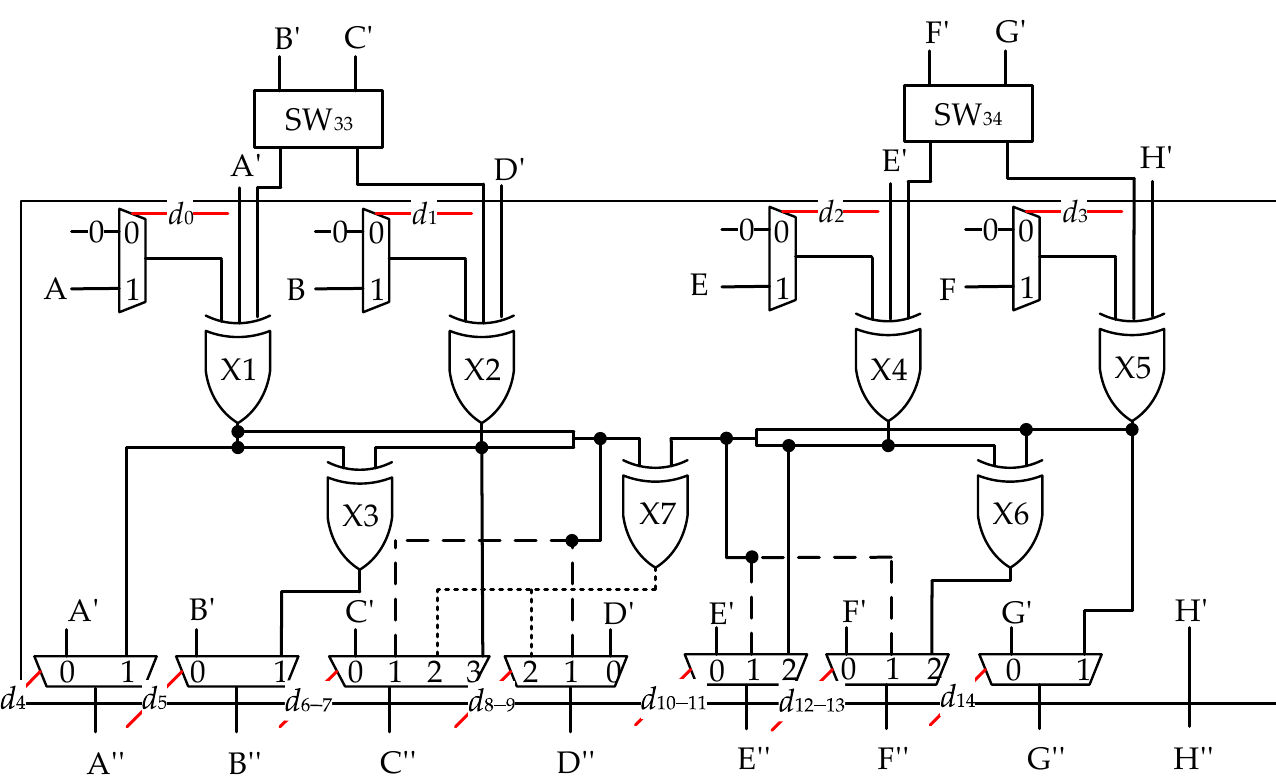
Figure 4. The circuit structure of the linear transformation processing module.